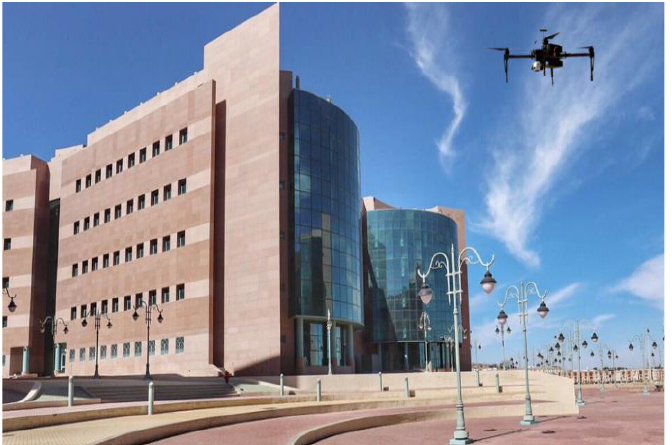
Figure 6. The proposed drone in the sky above Taif university campus for search-and-rescue trial.